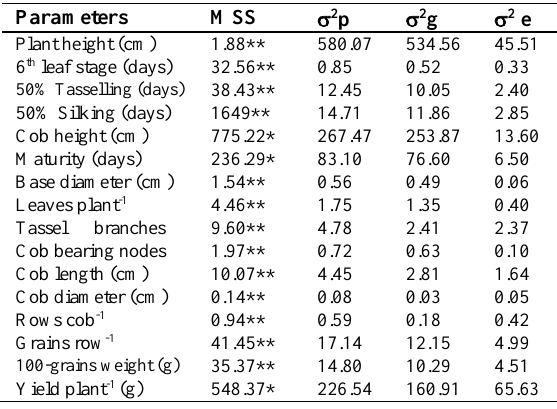
Table 3. Estimation of phenotypic, genotypic, and environmental variance for different characters of twenty-four F 3 populations of white maize.